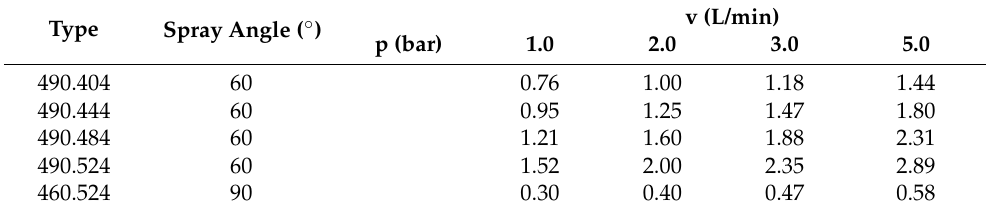
Figure 2. Simulated rainfall in the test on SK10 with 40-degree angle of inclination (I = 23 mm/h) with a detail of the sprinkler branch equipped with four axial-flow full cone nozzles. Table 2. Technical characteristics of the full-cone nozzles used to simulate rainfall: spray angle and flow rates (v) for different working pressures (p) (lechler.com accessed on 12 February